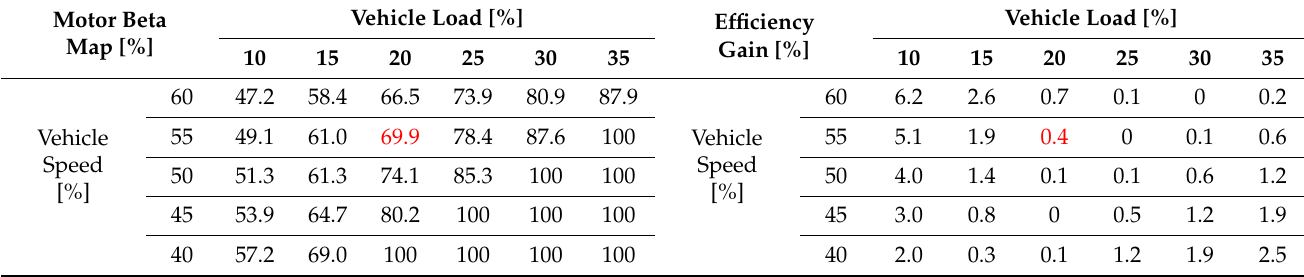
Table 6. Optimal motor displacement and efficiency gain for different working conditions (Solution C). The number in red represents the operation point shown in the above section. Motor